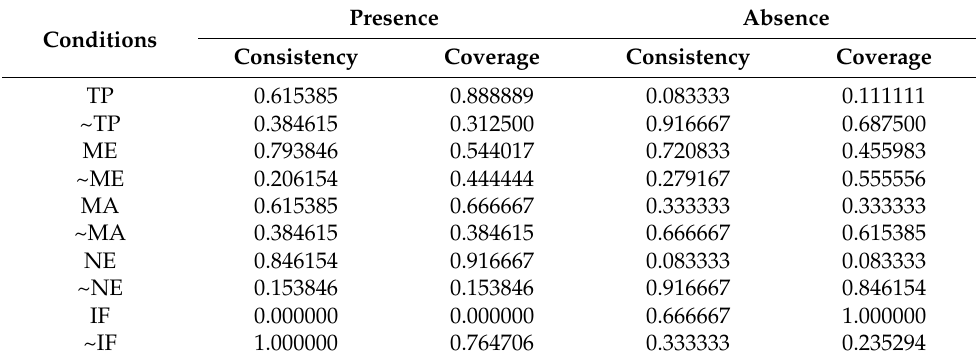
Table 3. Single-factor necessity